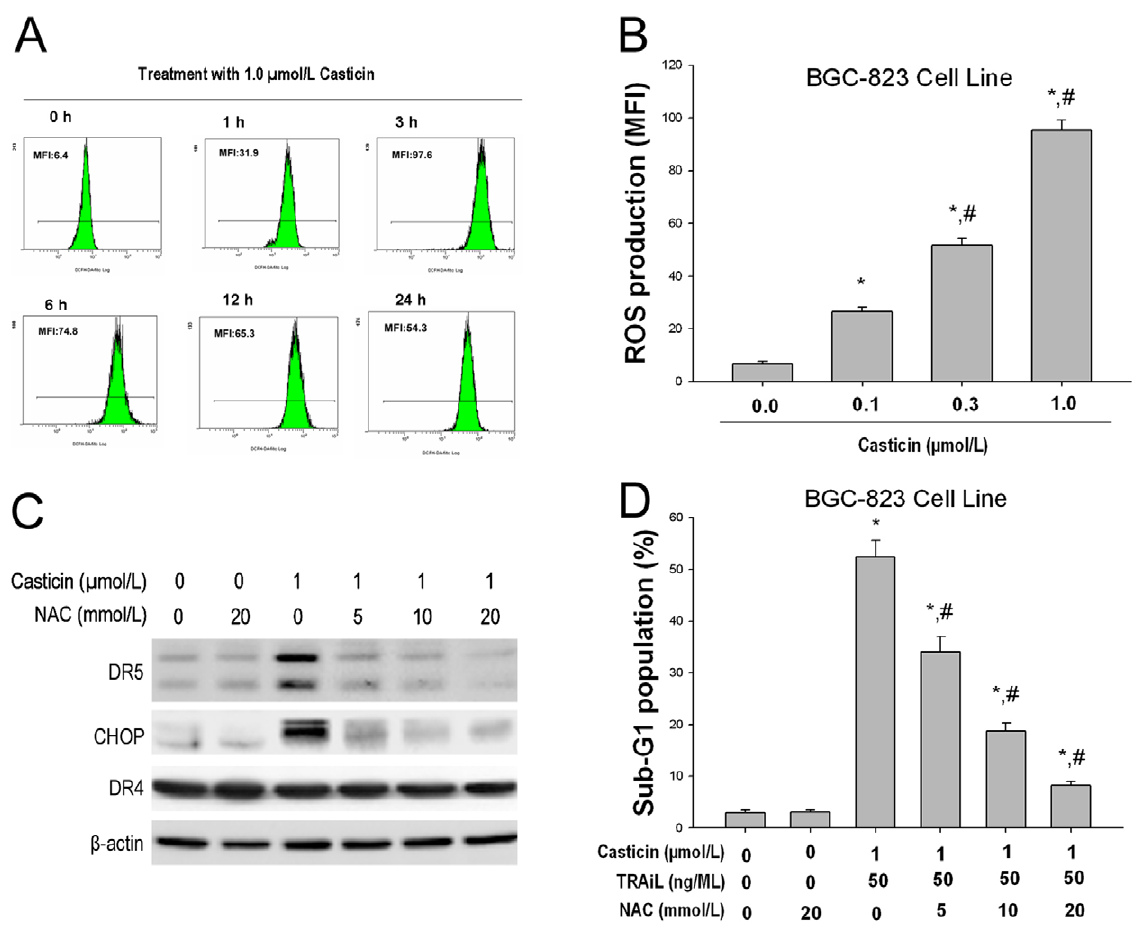
Figure 7. Casticin induced DR5 and CHOP upregulation and enhanced TRAIL-induced apoptosis of BGC-823 cells in a ROS- dependent manner. Effects of casticin on ROS generation (A and B) and the effects of NAC on casticin-induced DR5 and CHOP upregulation (C) using western blot analysis and TRAIL-mediated apoptosis (D) in BGC-823 cells (mean 6 SD, n =3). * P , 0.05 vs. treatment with DMSO; # P , 0.05 vs. treatment with 1 m mol/l casticin plus 50 ng/ml TRAIL in cells pretreated with NAC.